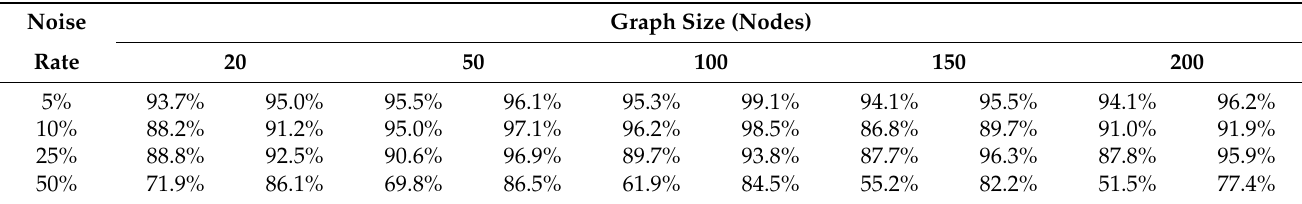
Table 1. Lost robot test: success rate of the node-matching